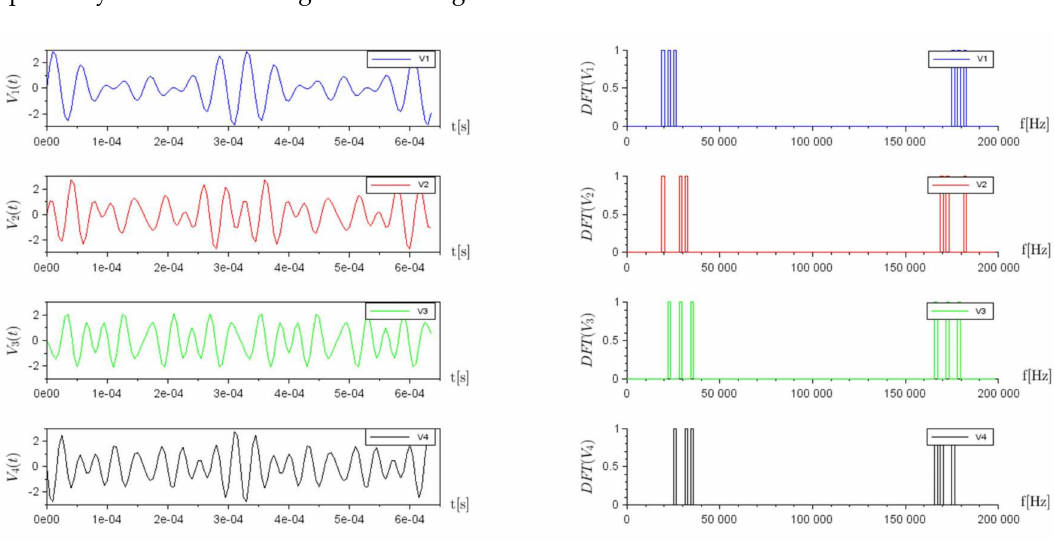
Figure 5. Excitation signals at each of the four electrodes, V 1 , V 2 , V 3 , V 4 . On the left, the time domain representation, and on the right, the frequency domain